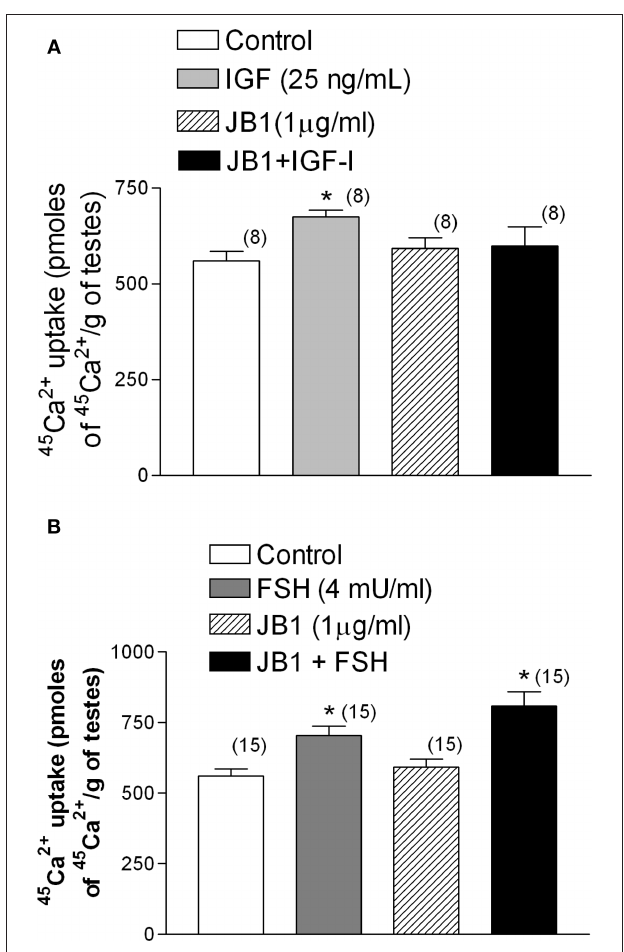
FiGure 7 | effect of the inactive analog of iGF-i, JB1 (1 μg/ml), on iGF-i (A) and FSH (B) stimulation of 45 Ca 2 + entry after 2 min of incubation. JB1 inhibited the stimulatory effect of IGF-I on 45 Ca 2 + entry, but not the action of FSH, on 45 Ca 2 + uptake. (A) * p < 0.05 as compared with the other groups, n in brackets from two independent experiments; (B) * p < 0.05 as compared with the other groups, n in brackets from three separated